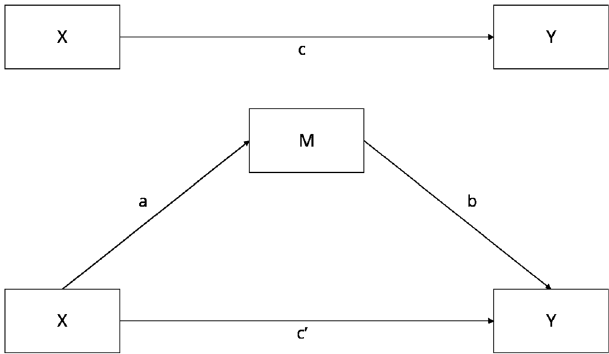
FIG. 1. Visual representation of Eqs. (1) to (3). The top graphic shows Eq. (1) while the bottom graphic shows Eqs. (2) and (3).